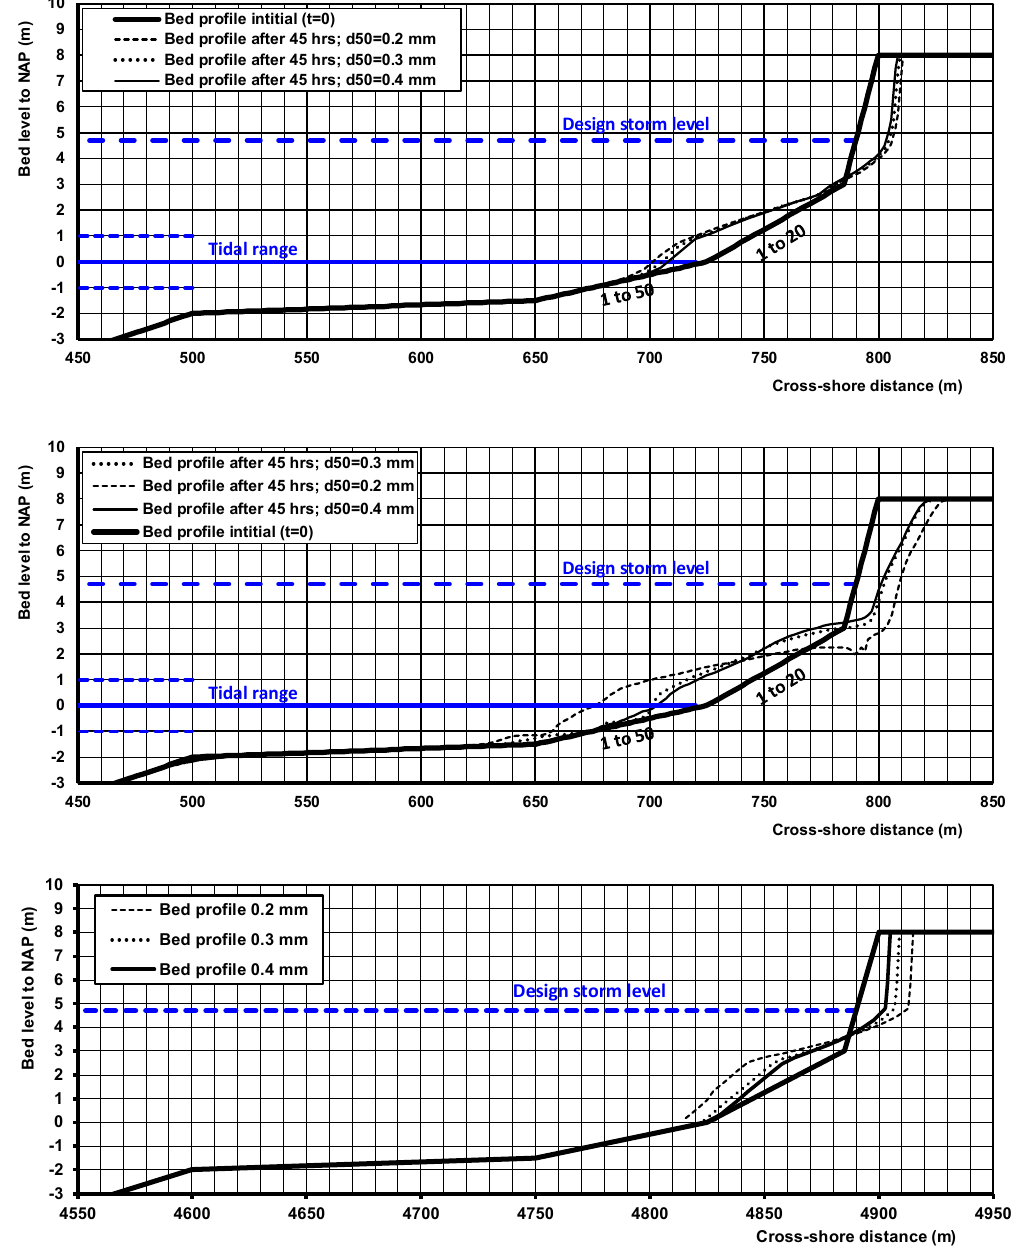
Figure 10. Computed dune erosion at transect 15; waves normal to coast; ( upper ) the Xbeach-model; (middle) the Crosmor-model; (lower) the Duros + -model.